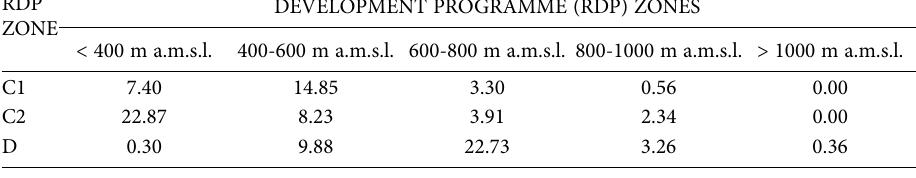
Distribution of farmland area in the sample (%) by ALTITUDE CLASSES inside each REGIONAL DEVELOPMENT PROGRAMME (RDP) ZONE < 400 m a.m.s.l.